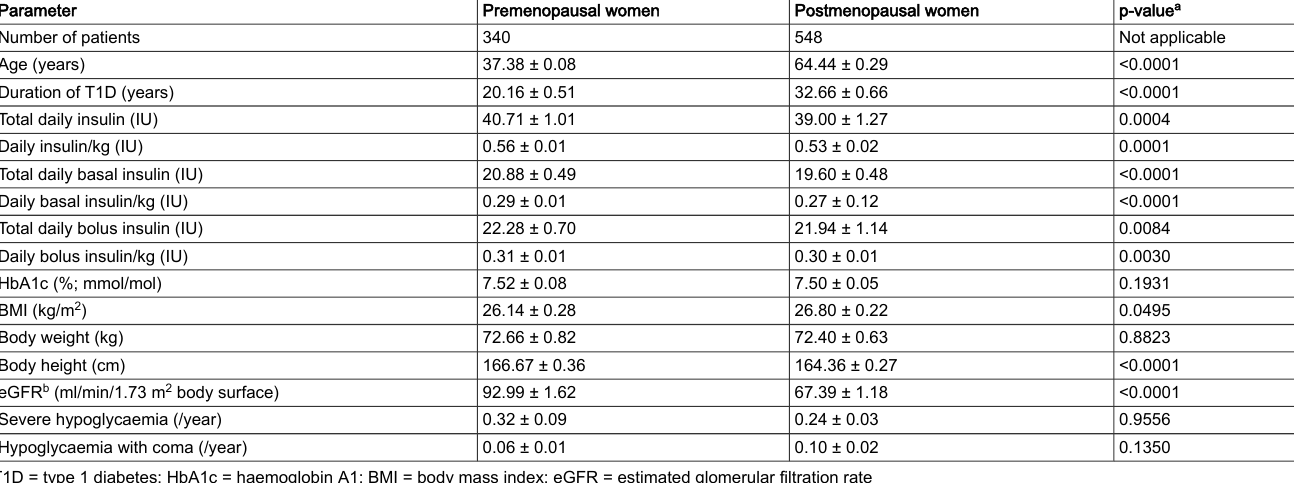
Table S1: Differences in demographic, clinical, and anthropometric parameters between premenopausal women (age ≥ 35 to <40 years) and postmenopausal women (age ≥ 55 years).